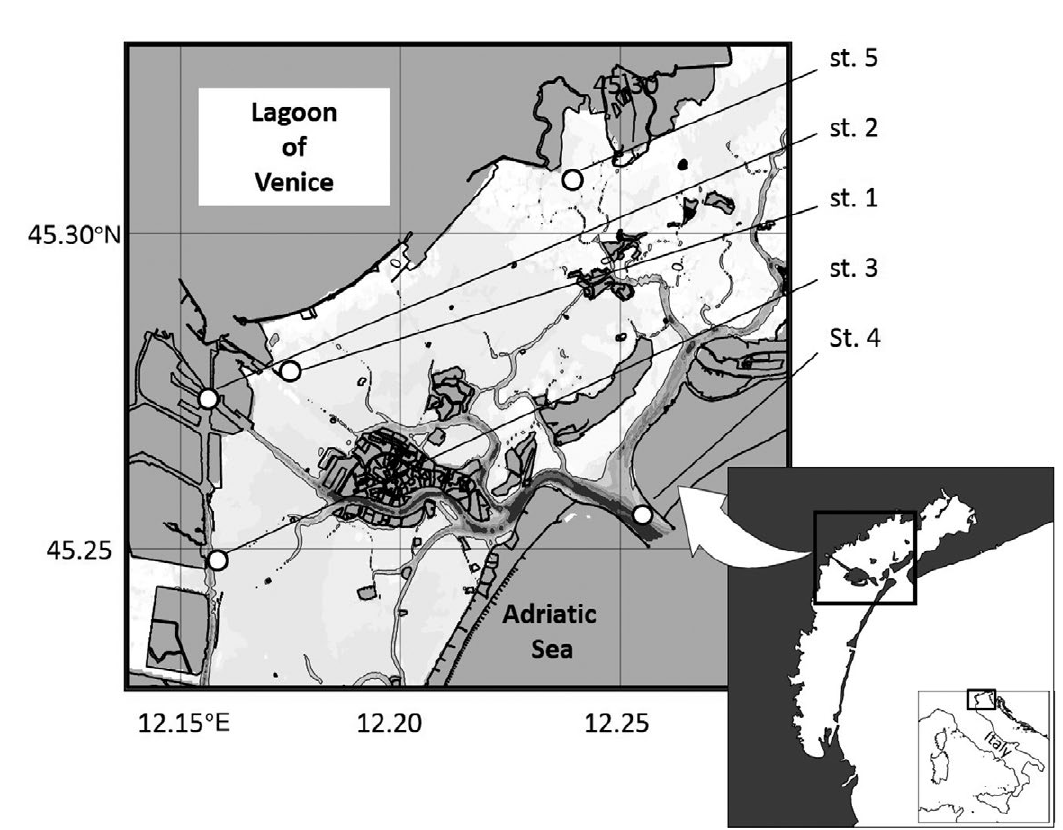
Fig. 1. – The Lagoon of Venice and the five sampling stations used for long-term data